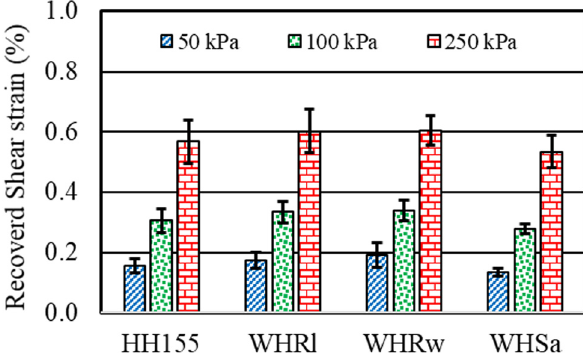
Figure 10: Recovered shear strain at each testing cycle of WMAs manufactured at 145°C.